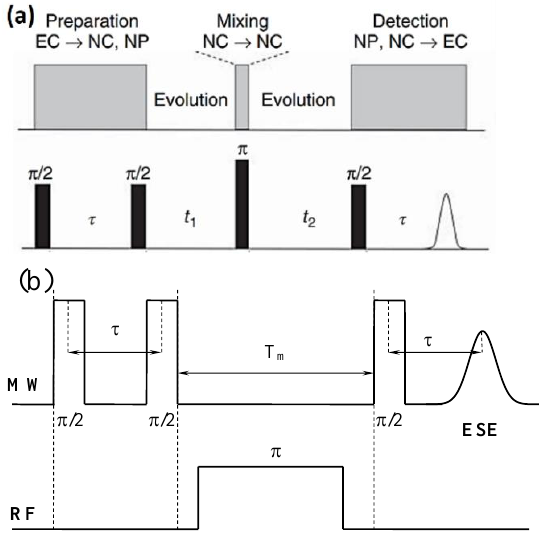
Figure 1. ( a ) Pulse sequence to acquire two-dimensional signals from electron–nuclear interactions (HYSCORE), where NP stands for nuclear polarization, NC stands for nuclear coherences, and EC stands for electron coherences; ( b ) pulse sequence to obtain Mims ENDOR spectra.